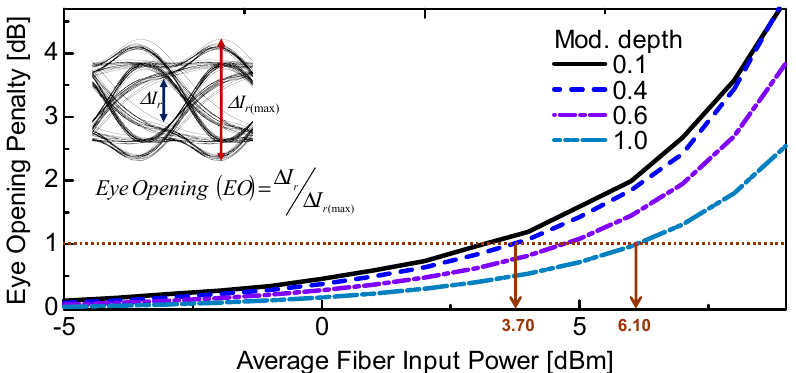
Figure 16. Eye-opening penalty of peak-folded OSSB-SC signal, inset: definition of eye-opening ( EO ), ∆ I r, and ( ∆ I r ) max are inside and outside eye openings, respectively.